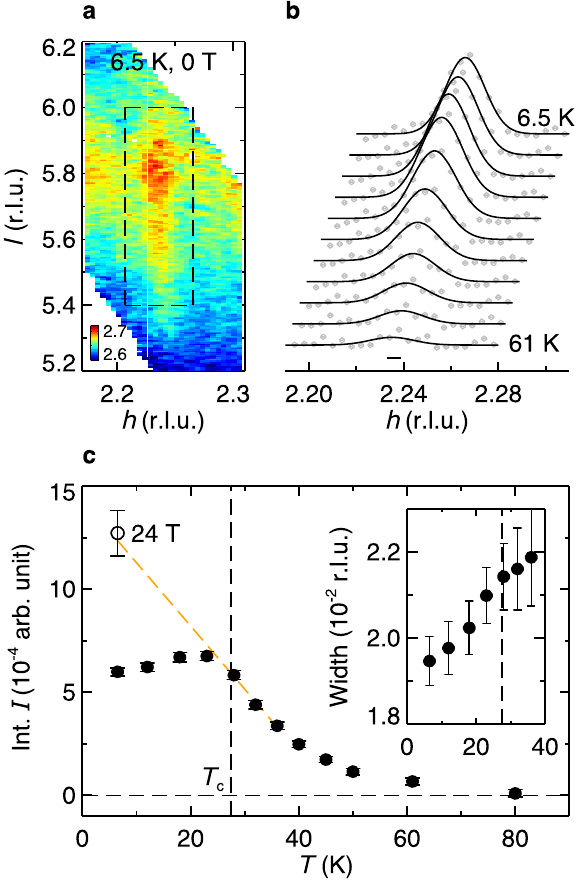
Fig. 1 | Temperature dependence of CDW in LSCO. a CDW intensity map mea- suredat6.5K,0T,projectedonto hl plane,integratedover k [ − 0.02,0.02]r.l.u.The dashed black rectangle encircles the CDW peak. b Temperature-dependent h -cuts through the CDW peak. Solid lines are single-peak fi ts to the data. A linear back- ground has been subtracted, and data are shifted for clarity. The horizontal bar represents instrumental resolution. c Integrated CDW intensities extracted from the single-peak fi ts. The inset shows the corresponding peak width. The orange dashedlineisalinearextrapolationoftheCDWintensitiesat28K,32K,and36Kto lowertemperatures T < T c